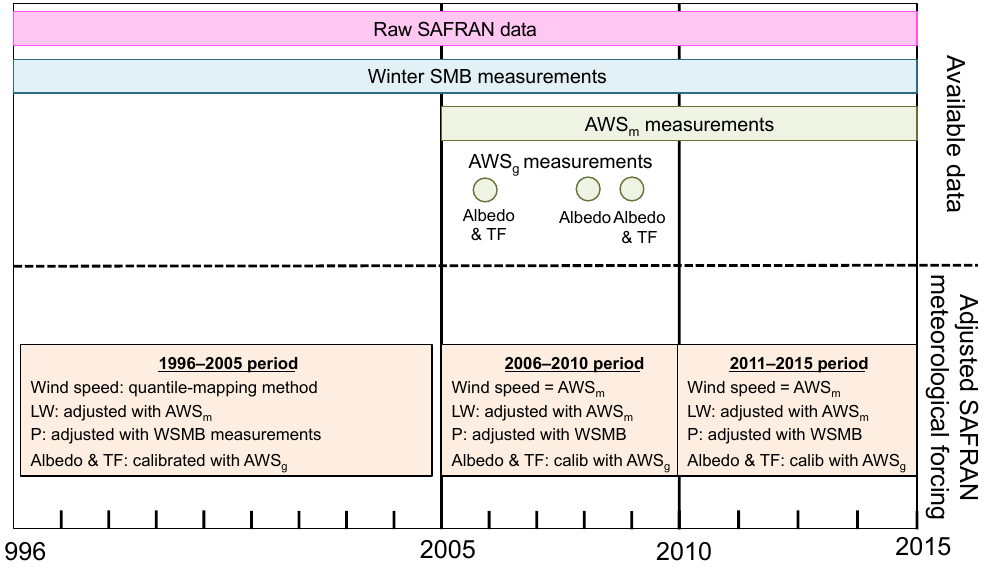
Figure 2. Summary of available meteorological data and the adjustments of the raw SAFRAN data, depending on the study period ( P : precipitation; TF: turbulent